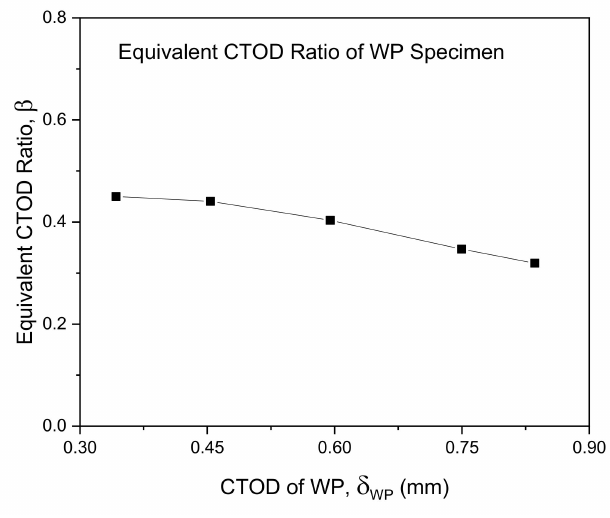
Figure 15. Equivalent CTOD ratio of the WP specimens.